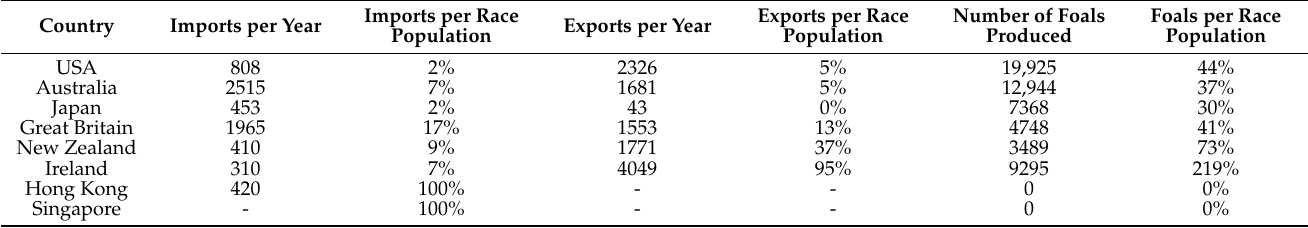
Table 2. Import and export data estimated for major racing nations for the 2019